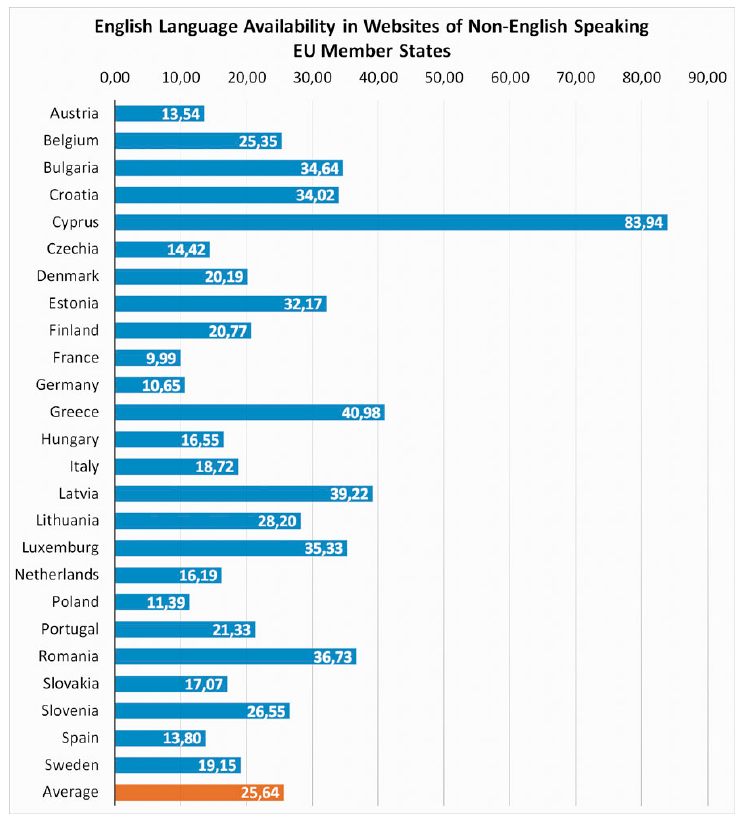
Figure 7. English Language Availability in Websites of Non-English Speaking EU Member States.